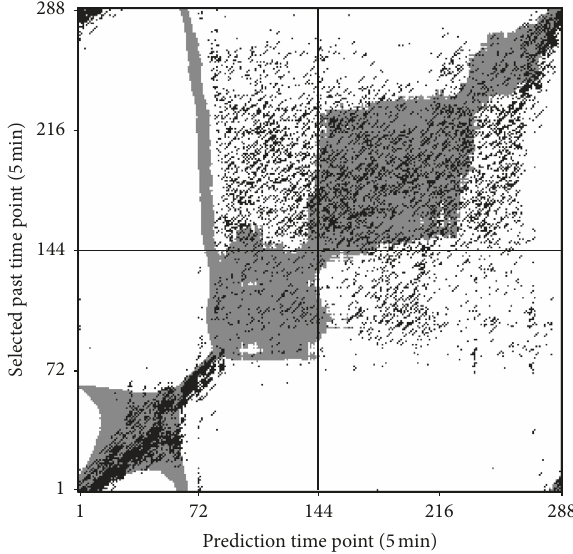
Figure 5: Comparison of a fixed data segment and S2S-based selected time points.